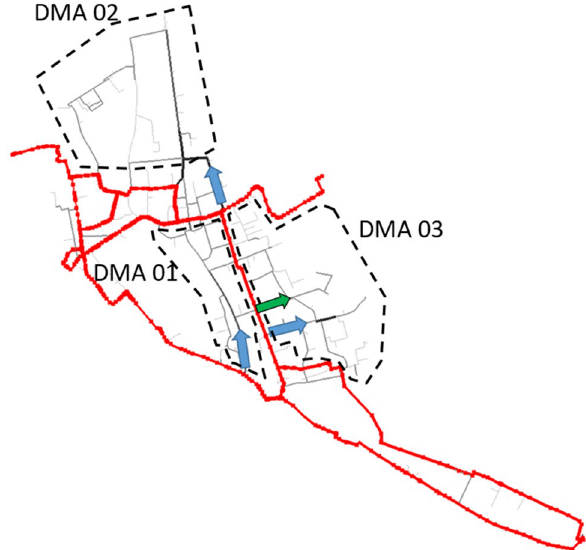
Fig. 8 Directions of DMA water supply (blue arrows). The transmis- sion segments were marked in red, whereas the new pipe supplying DMA 03 was marked as a green